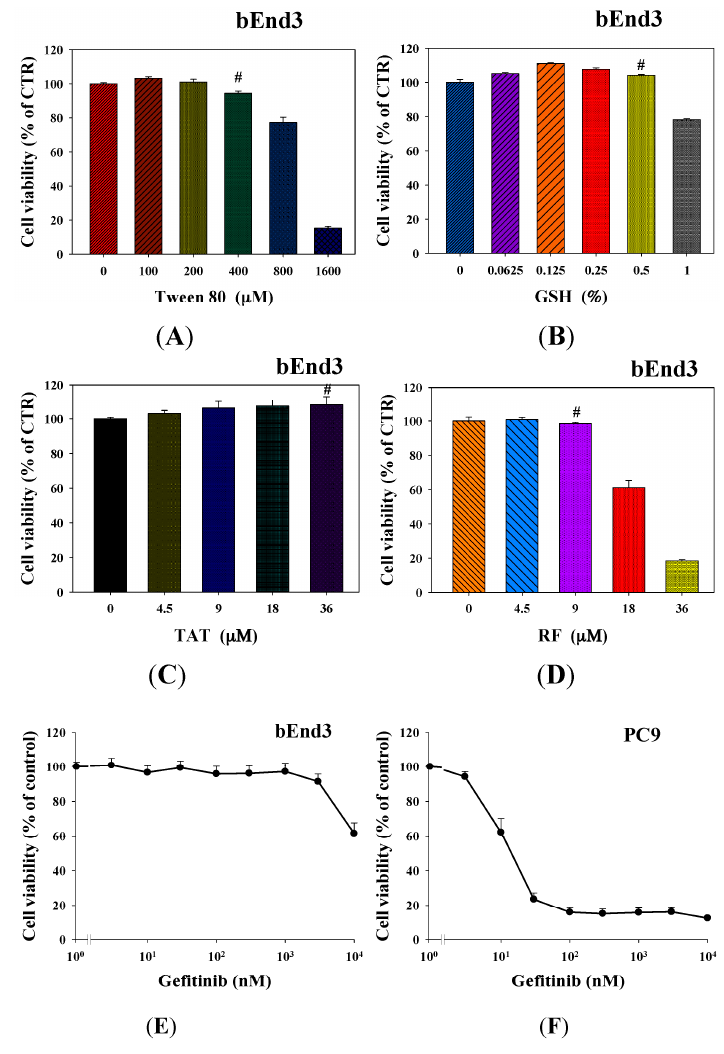
Figure 4. Cytotoxic effect of gefitinib, Glutathione (GSH), Tween 80, trans-acting activator of transcription (TAT), and RF on PC9 and bEnd.3 cells. bEnd.3 cells were cultured for 24 h with various concentrations of: ( A ) Tween 80; ( B ) GSH; ( C ) TAT; and ( D ) RF. Cell viability was determined using SRB assay. ( E ) bEnd.3 were cultured in various concentrations of gefitinib for 96 h. ( F ) PC-9 were cultured with various concentrations of gefitinib for 48 h. Cell viability was determined using the sulforhodamine B (SRB) assay. Values are the mean ± SEM. ( n = 3). # represents the non-cytotoxic concentrations of GSH, Tween 80, TAT, and RF, which were used in the following experiments.